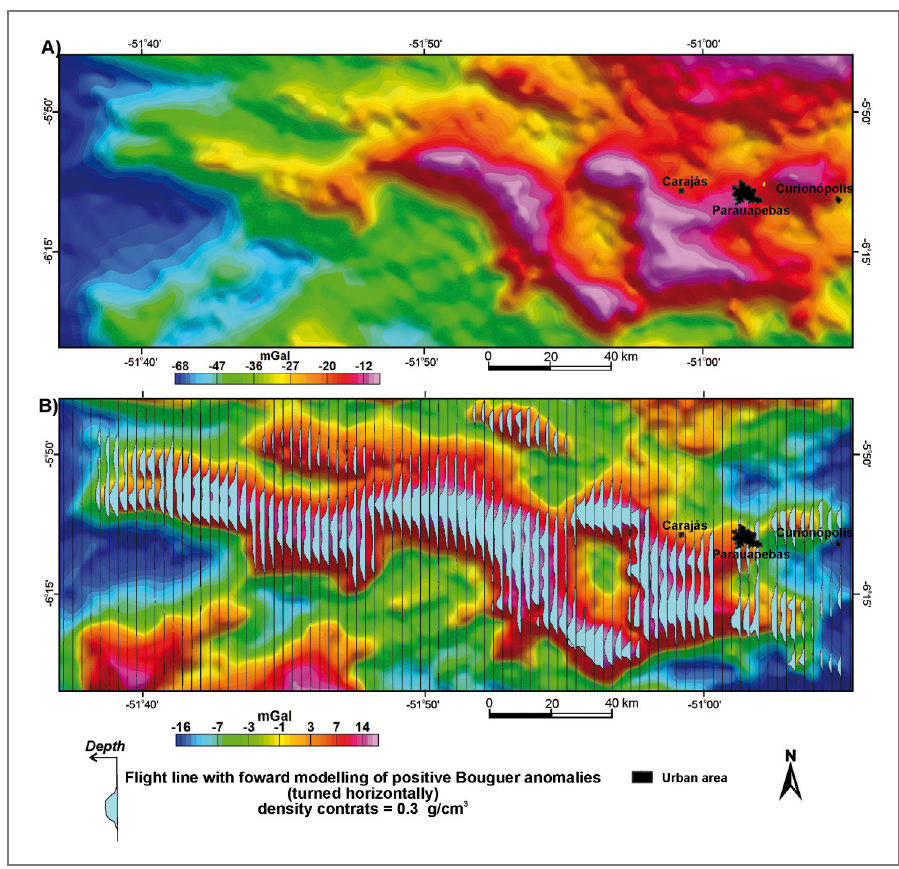
Figure 3 - A) Bouguer gravity anomalies of the Carajás Basin and surroundings; B) Bouguer gravity anomalies with first order trend removed, flight lines and results of the forward modeling of the positive anomalies (turned